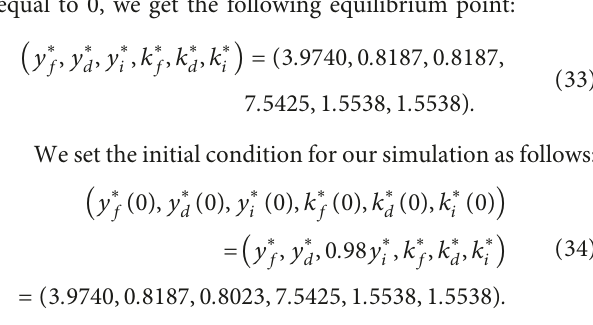
y y k k f , d , i , f , d , and